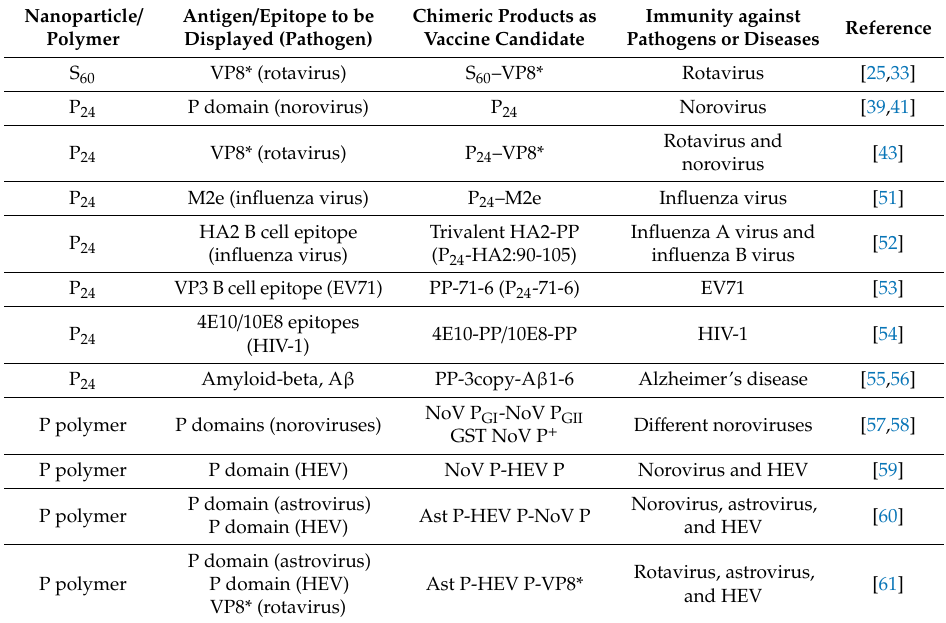
Table 1. Summary of norovirus nanoparticles and polymers as vaccine candidates and platforms to display foreign antigens and